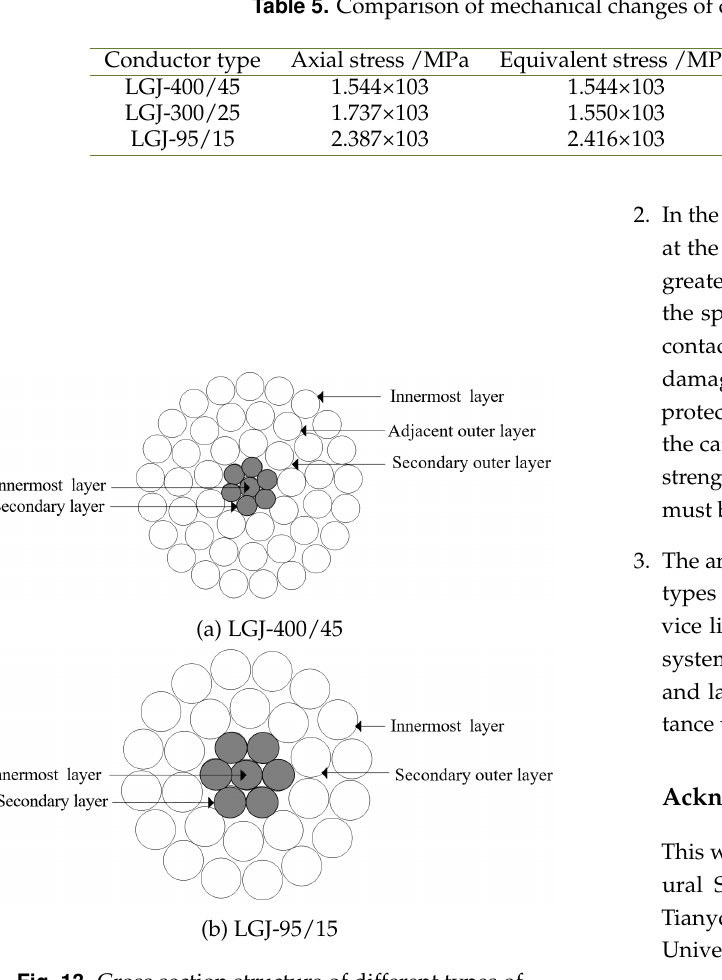
Fig. 13. Cross section structure of different types of